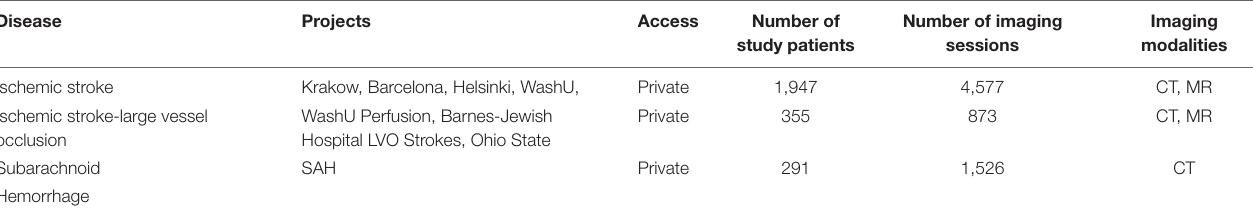
Number of imaging Imaging study patients sessions modalities 355 873 CT, MR